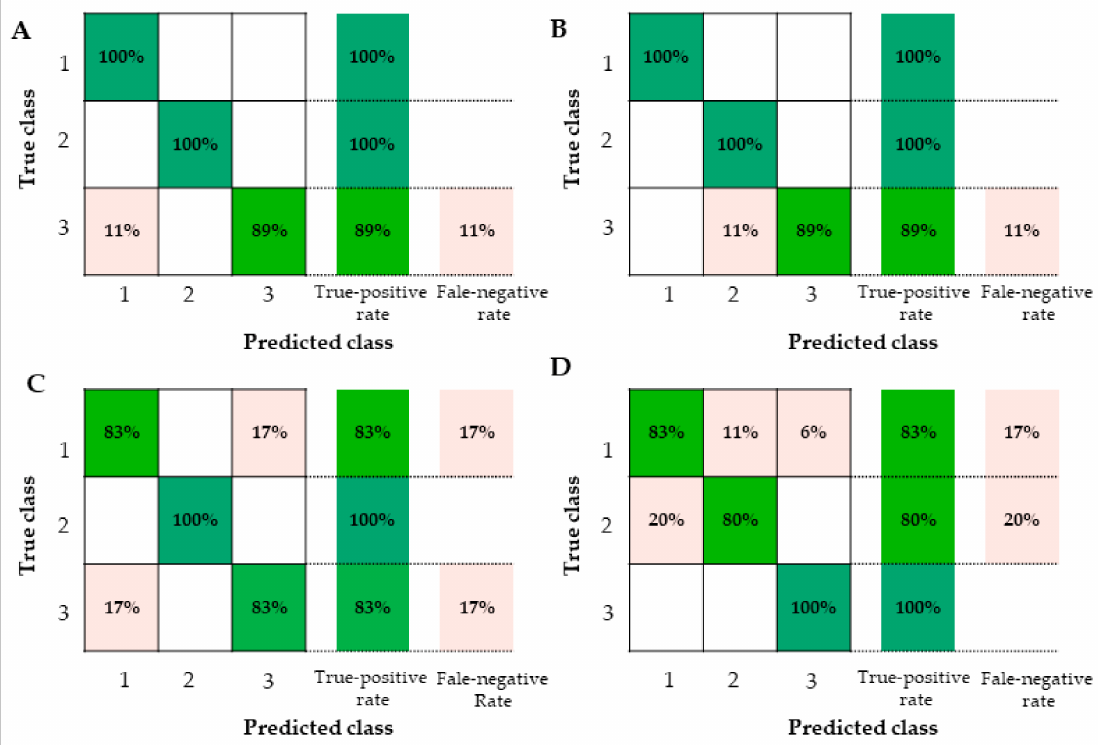
Figure 7. Confusion matrix of electronic tongue for yolks, albumen, and eggs by classification algorithms. ( A ) Confusion matrix for yolks by linear discriminant analysis (LDA). ( B ) Confusion matrix for yolks by fine tree. ( C ) Confusion matrix for albumen by linear discriminant analysis (LDA). ( D ) Confusion matrix for whole eggs by fine K-nearest neighbor (KNN). Number 1, Wuhei (W); Number 2, Beinong No.2 (B); Number 3, Hy-Line Brown